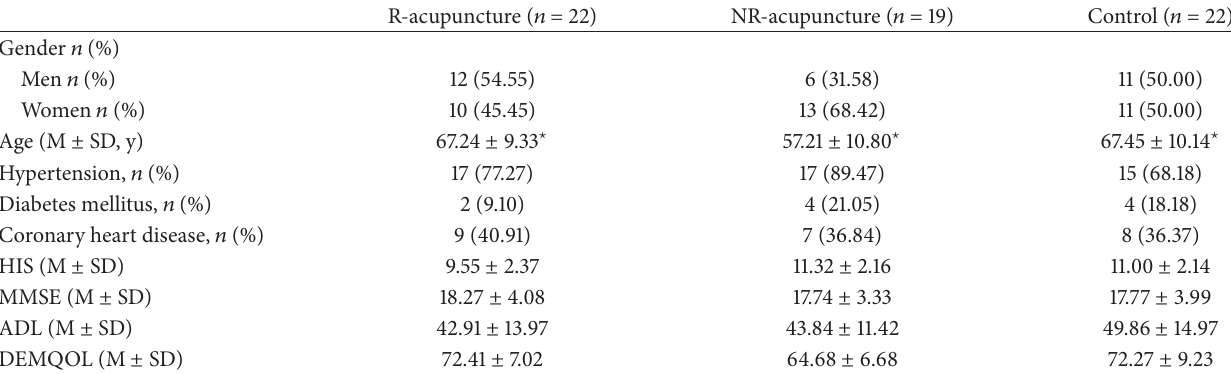
Table 1: Subjects’ baseline